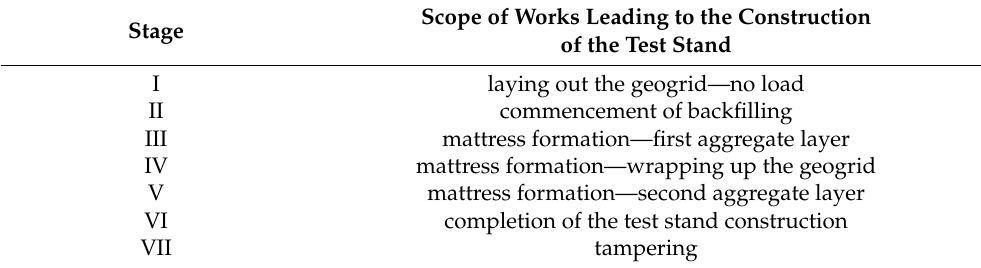
Table 3. Stages of the preparation of the test stands for the monitoring of the assumed road structure with a reinforcement element in the form of a geosynthetic mattress.